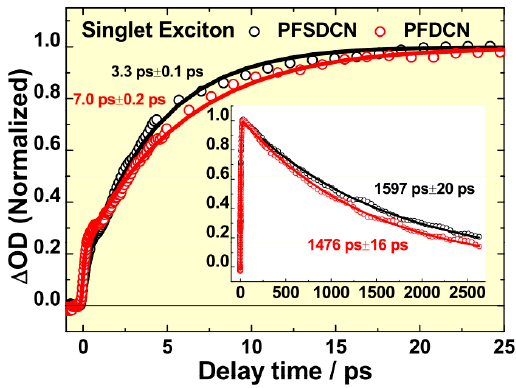
Figure 9. Comparison of S 1 → S n singlet exciton arising kinetics of PFDCN (red) and PFSDCN (black) solution. Insert shows the kinetics up to 2.5 ns for clearer view of the decay process. Solid lines are fitting curves based on multi-exponential model functions.